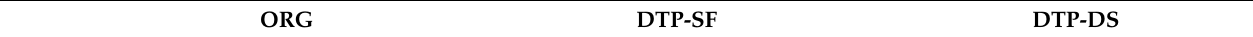
Table 11. Pros and cons of different winding configurations under maximum torque